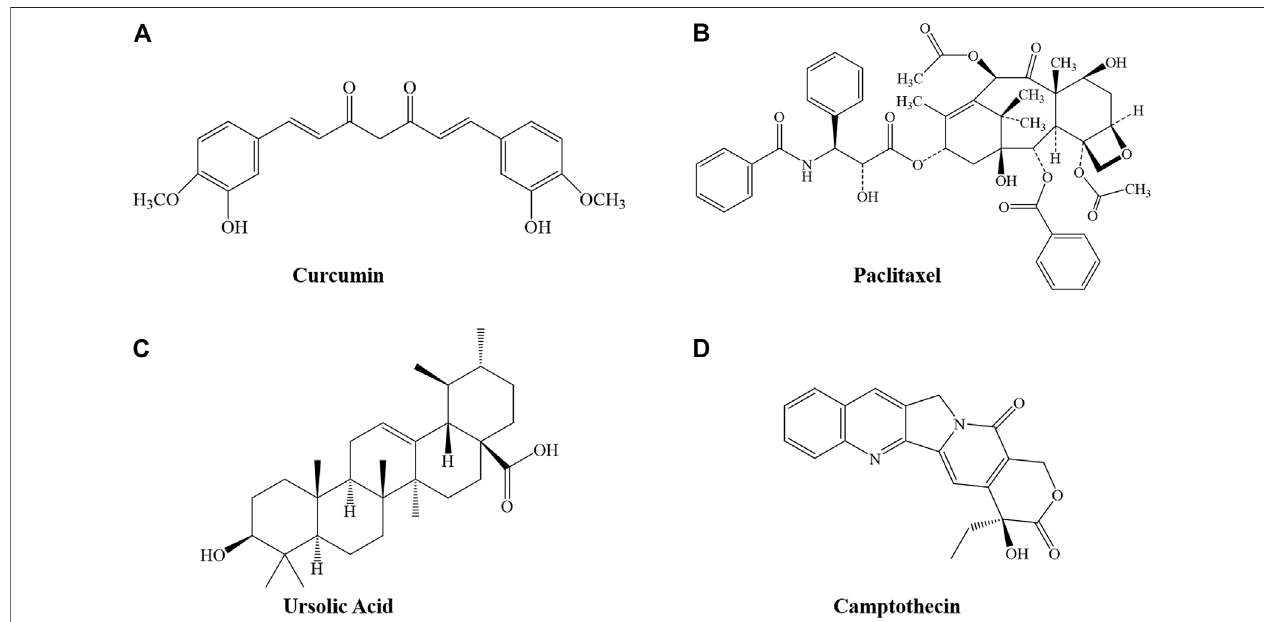
FIGURE 1 | Structure of several phytochemicals. (A) Curcumin, (B) Paclitaxel, (C) Ursolic Acid, and (D)